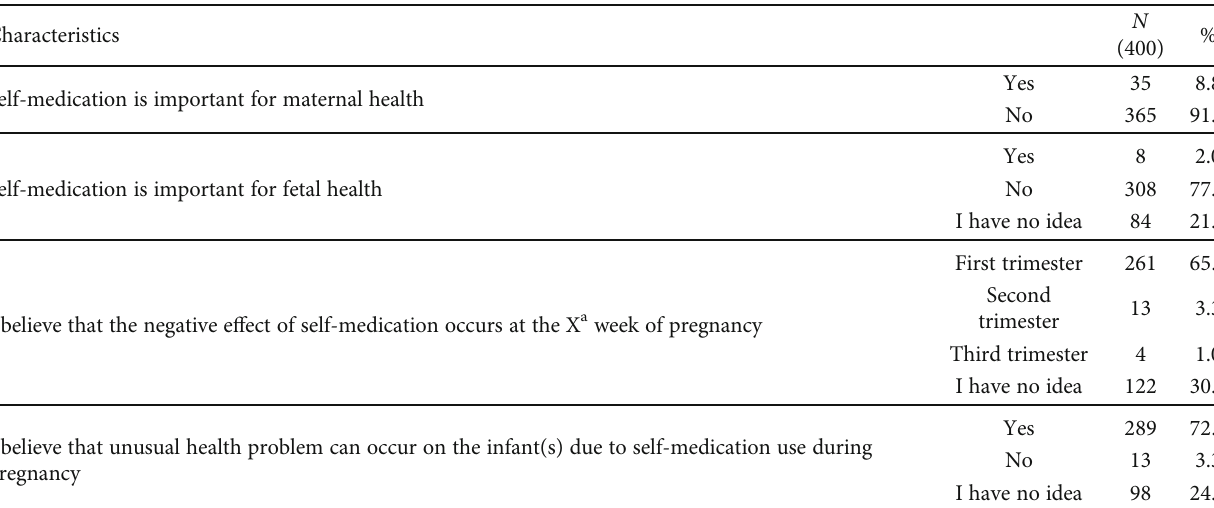
Table 3: Pregnant women ’ s attitude towards self-medication at UoGCSH, June